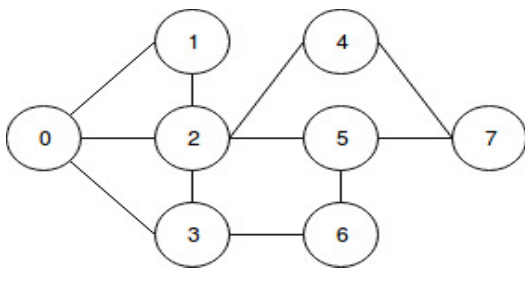
Figure 3. Network with 8 nodes.